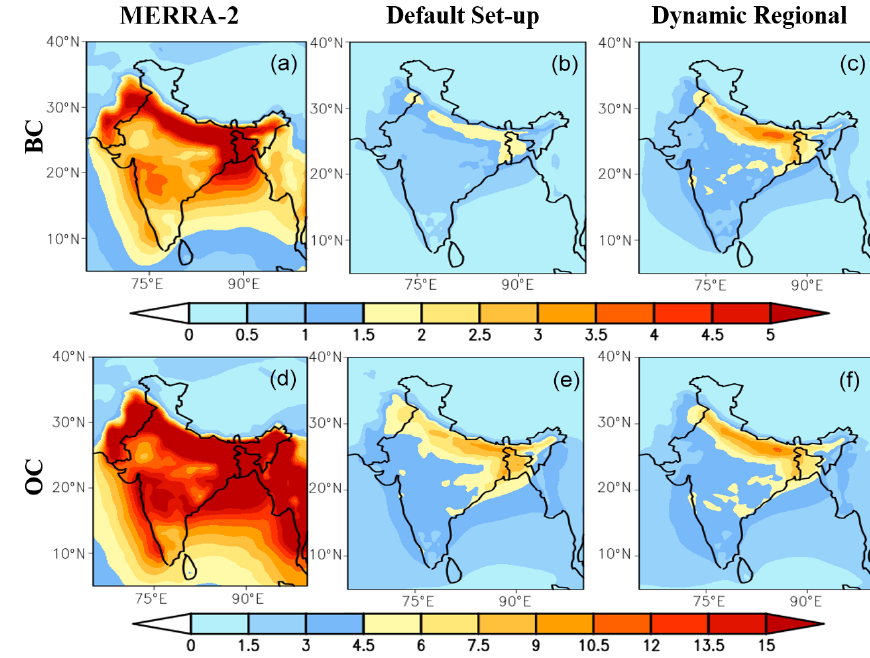
Figure 3. Comparison of spatial patterns of the annual (a, b, c) BC and (d, e, f) OC column burden (mgm − 2